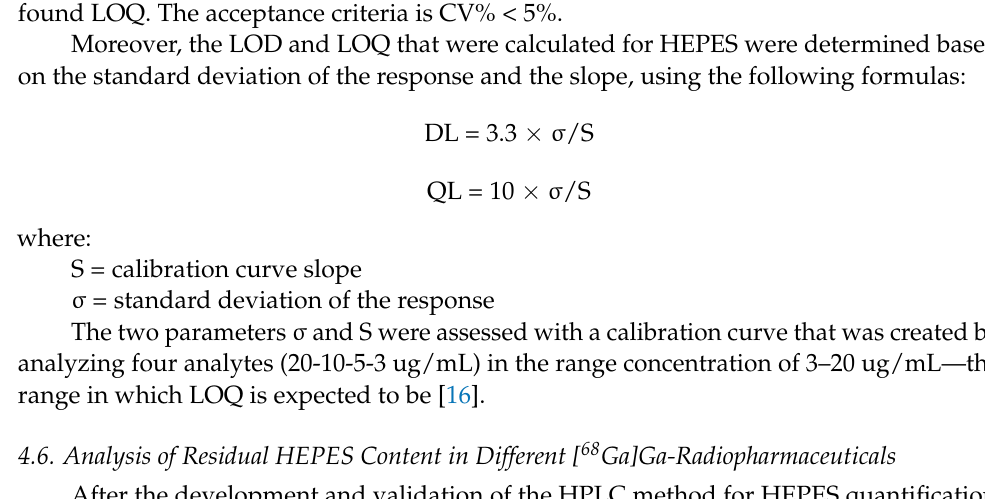
Table S3: Accuracy and inter-day precision for the HPLC method used for HEPES ( n =